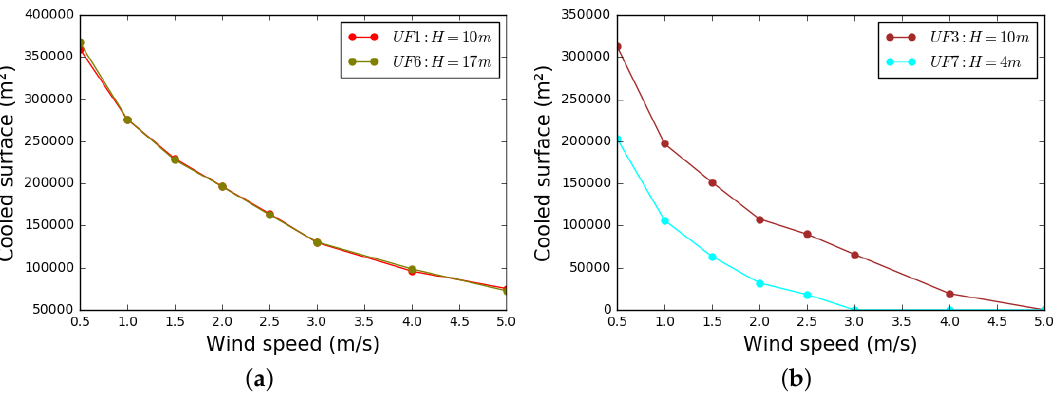
Figure 9. Influence of wind speed on the cooled surface for various building heights. ( a ) For a low building density district; ( b ) For a high building density district.